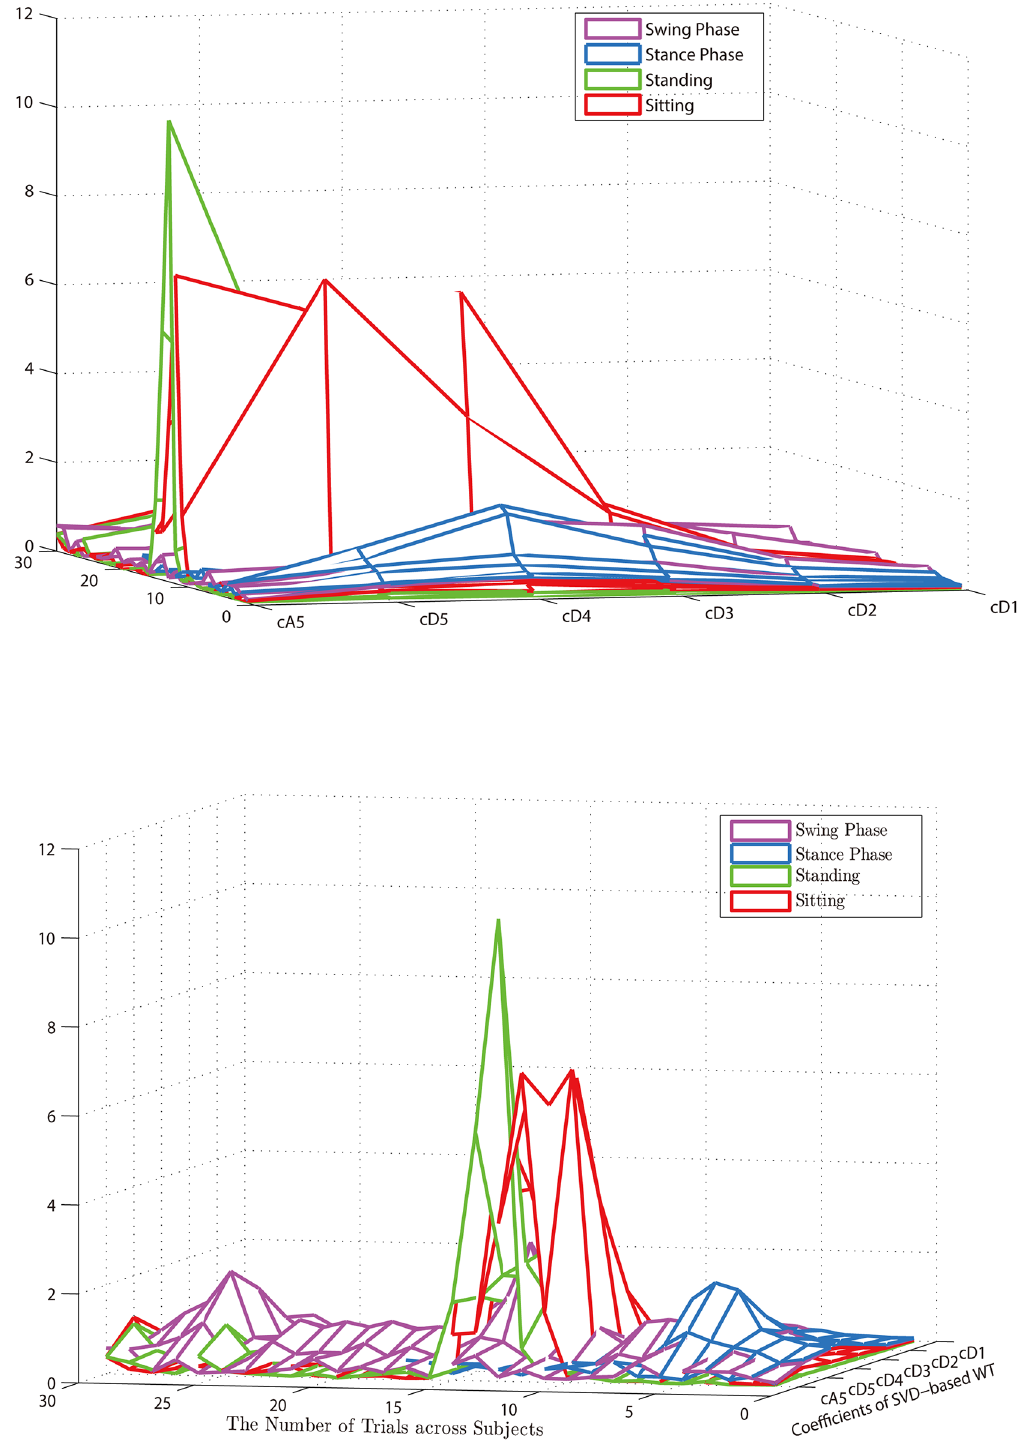
Fig 5. The WT-based SVD features for all trials with four lower-limb motions.